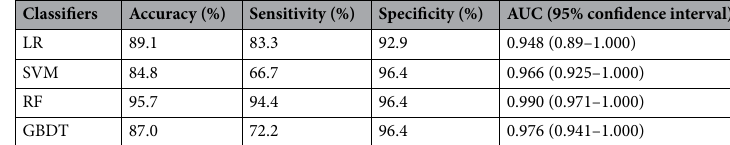
Table 2. Subtype predictive accuracy and area under the receiver operating characteristic curve of unilateral subtype of primary aldosteronism for each classifier in the test cohort (n = 46). AUC indicates area under the receiver operating characteristic curve; LR, logistic regression; SVM, support vector machines; RF, random forests; GBDT, and gradient boosting decision trees.